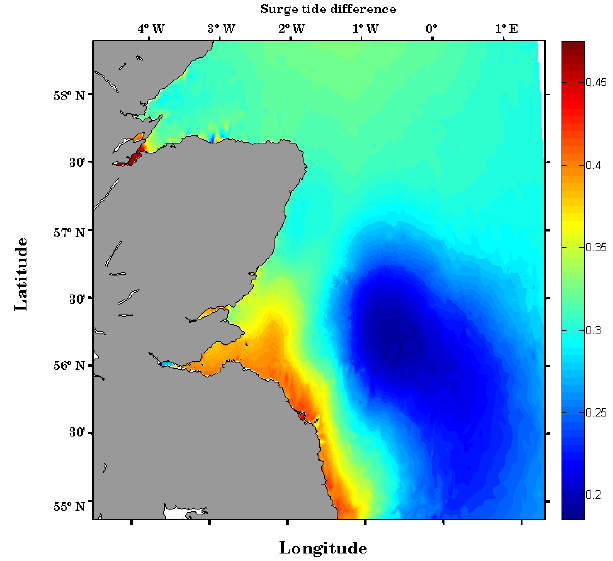
Figure 13. The modelled surge wave due to the local wind and pres- sure at 02:00UTC on 31 March